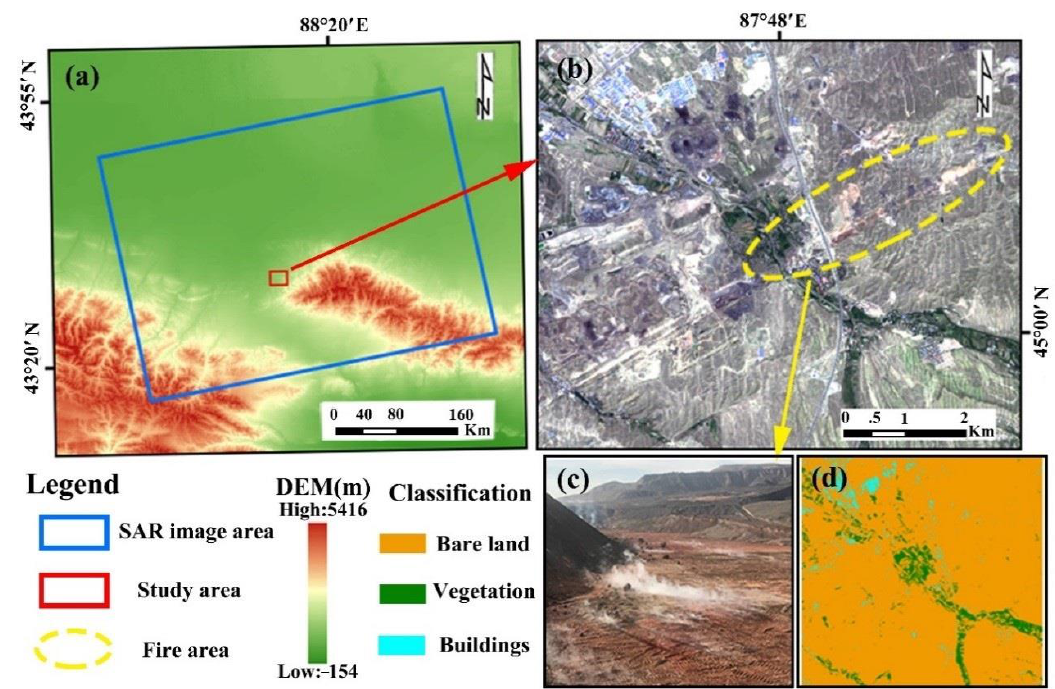
Figure 1. Sketch map of the study area: ( a ) Location and topography of the study area; ( b ) Sentinel-2 true-color image of the study area; ( c ) In-situ photo of the study area; ( d ) Ground feature classification map.